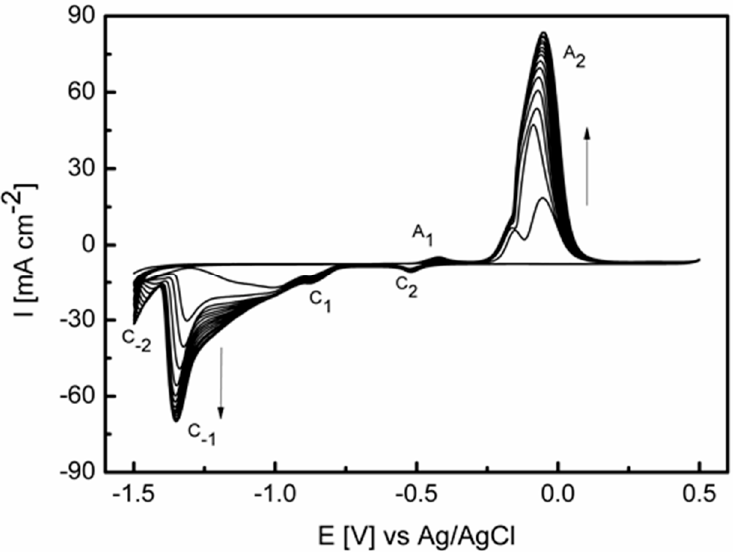
Figure 1. Repetitive cyclic voltammograms (20 cycles) recorded at a Cu foil electrode in 1 M NaOH containing 1 M ethanol at 10 mV s − 1 .